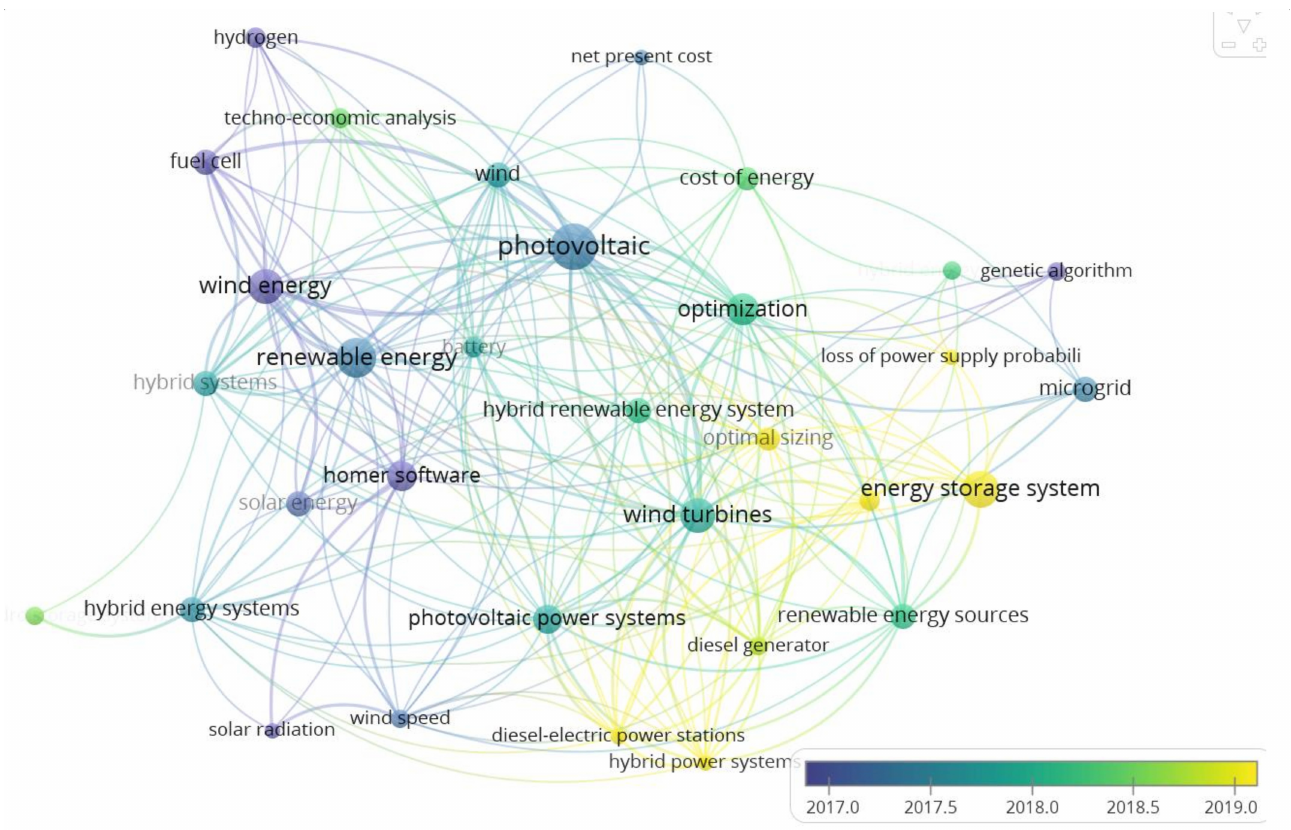
Figure 4. Keyword co-occurrence map.